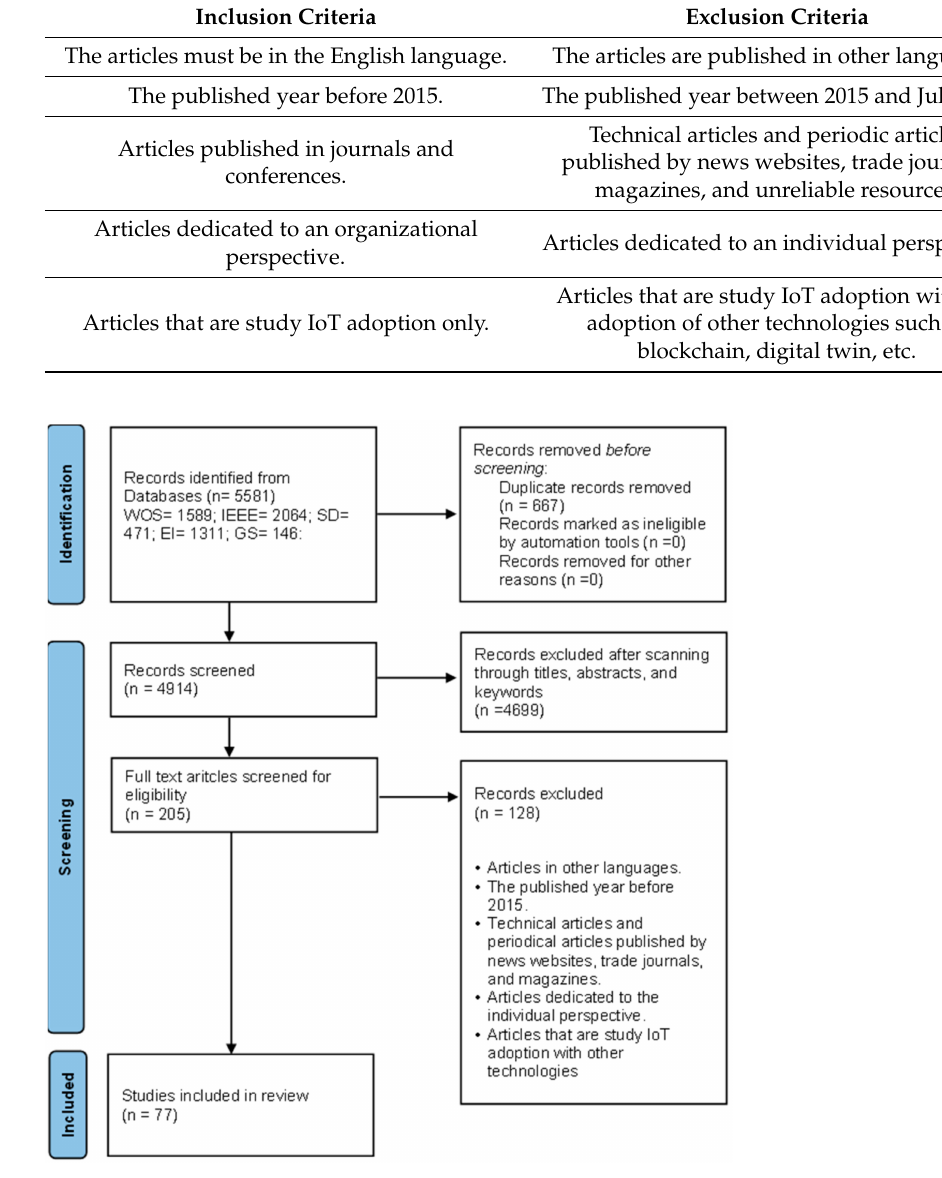
Figure 1. PRISMA flow diagram for the systematic